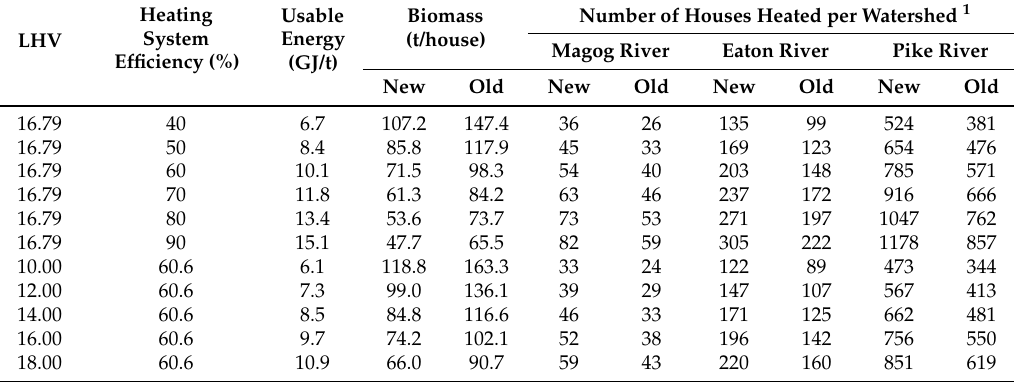
Table 9. Effect of the variation in heating system efficiency or lower heating value (LHV) of hybrid polar biomass on the usable energy content of biomass, on the biomass requirement per farmhouse and on the number of farmhouses that could be heated for each watershed after 9 years following the replacement of 100% of non-managed herbaceous buffers by hybrid poplar buffers along all streams (perennial + intermittent).